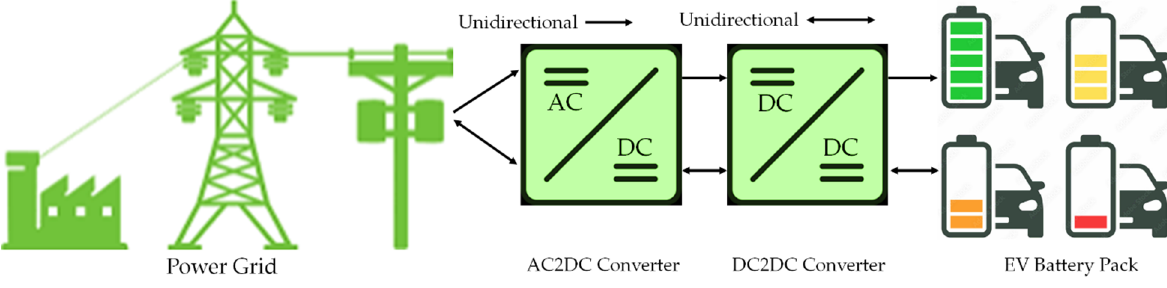
Figure 4. Power flow topology.